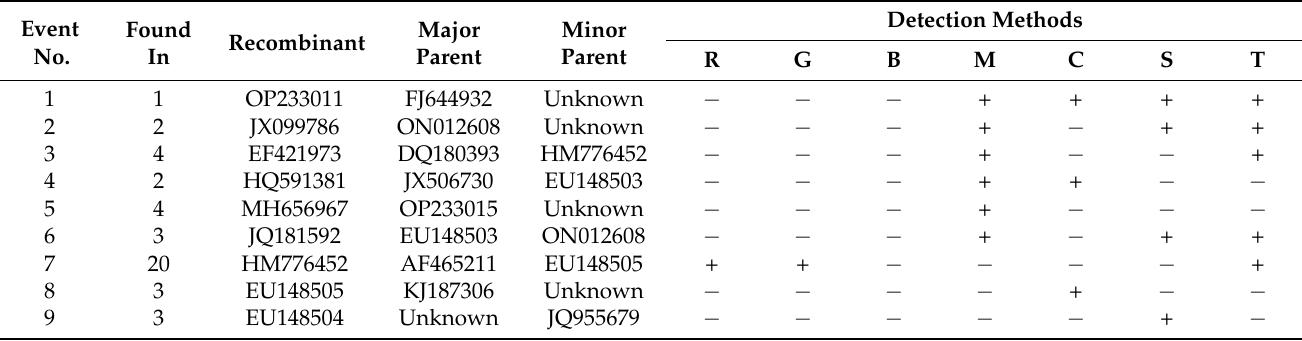
Table 1. Recombination information.